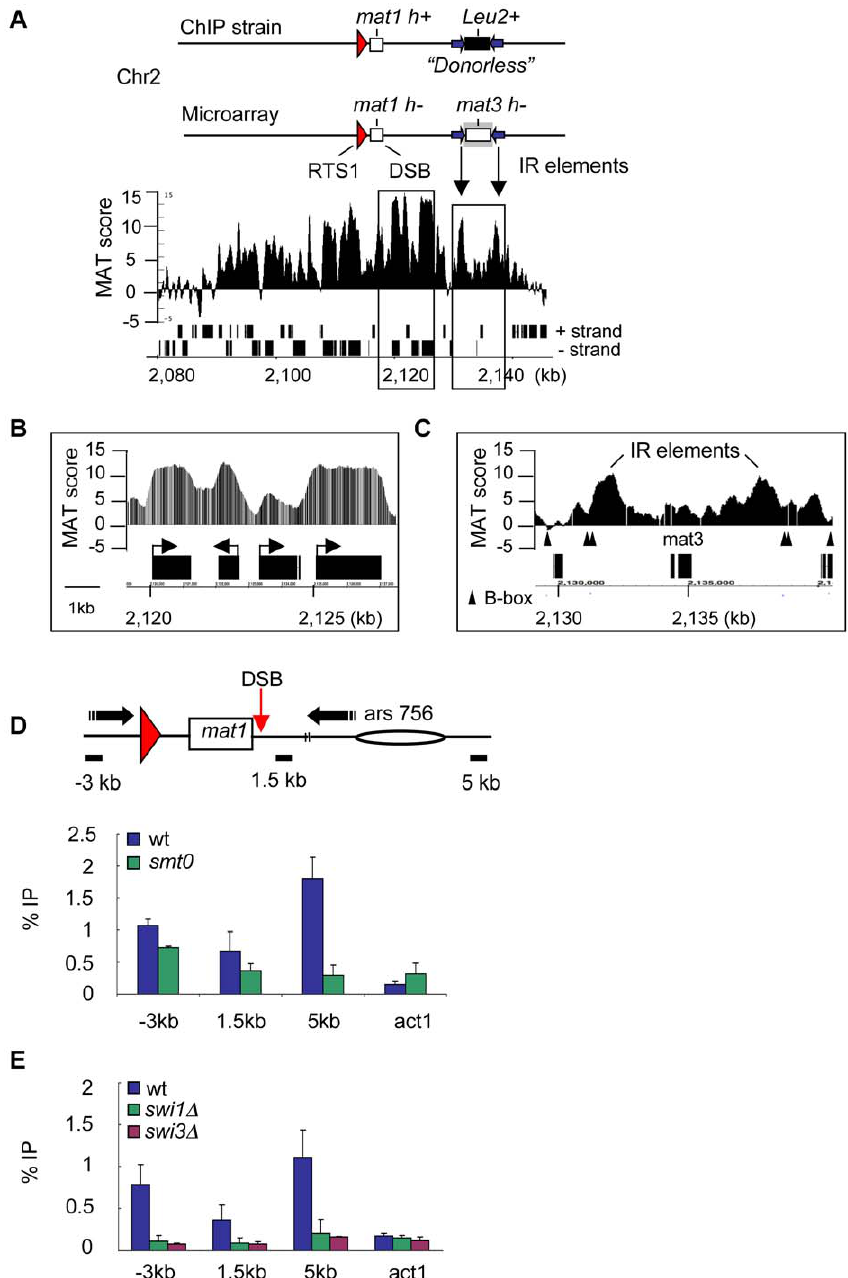
Figure 3. The RTS1 fork barrier at the MT locus triggers c H2A formation. (A) Detailed landscape of c H2A in the MT locus as determined by ChIP-on-chip analysis in Figure 2A. The top diagram compares the MT locus configuration of the Donorless ChIP strain to sequences present on the Affymetrix S. pombe Tiling 1.0 FR microarray. Locations of key features correspond to the ChIP-on-chip data coordinates shown below. Both strains contain the RTS1 barrier. The ChIP strain is mating-type h + at mat1 , and lacks the silent donor alleles, which were replaced with a Leu2 marker. The microarray strain is mating-type h- at mat1 and contains only the mat3-h- donor allele. Both strains contain inverted repeat (IR) elements flanking the Leu2 or m at3 cassettes (purple arrows). Black rectangles below plot represent genes. Black boxes correspond to magnified regions shown in (B) and (C). (B) An example of preferential enrichment of c H2A in gene coding regions. (C) Detailed examination of c H2A at the IR boundary elements shows that c H2A spreading is restricted by B-box sequences (black triangles). (D) The RTS1 fork barrier leads to c H2A in the absence of the DSB. c H2A ChIP was performed in wild type and smt0 strains synchronized by cdc25-22 block. Diagram shows qPCR primer locations (black rectangles) relative to the DSB at Mat1. (E) c H2A formation at the MT-locus depends on Swi1-Swi3. c H2A ChIP was performed in the indicated strains as in (D) The locations of qPCR primers are indicated in diagram in (D). doi:10.1371/journal.pgen.1001032.g003 nonpolar and weaker than RTS1, and fork stalling at tDNAs does of Swi1 increases recombination at tDNAs, likely from increased not depend on Swi1 [56]. However, Swi1 has a general role in collisions between the replisome and transcription [56]. We facilitating replisome progression through tDNAs and the absence analyzed the effect of Swi1 deletion on c H2A levels near the